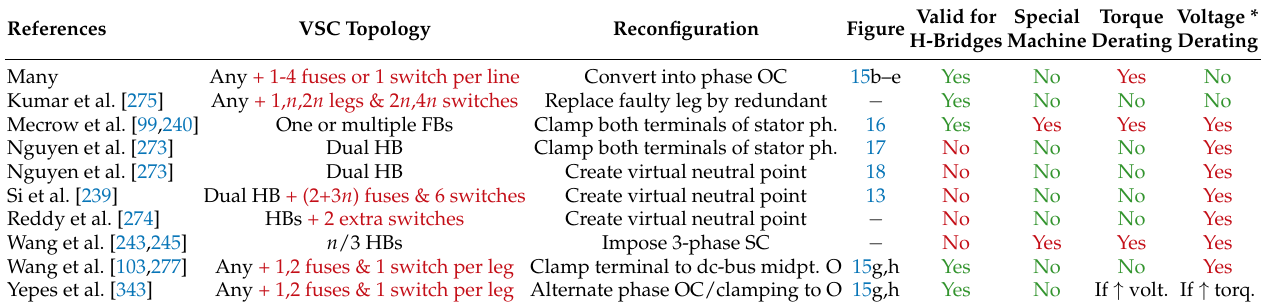
Table 16. Methods based on drive topology reconfigurations for tolerating switch SC faults in multiphase applications in the literature.